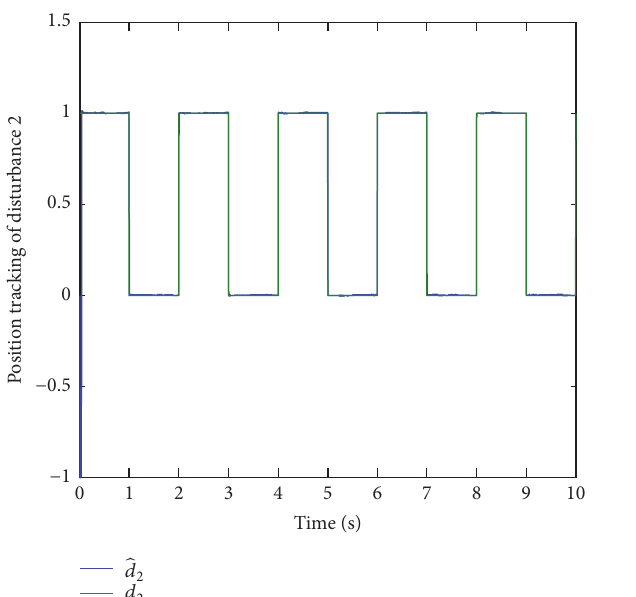
Figure 14: Actuator fault 𝑓 𝑎2 and its reconstruction